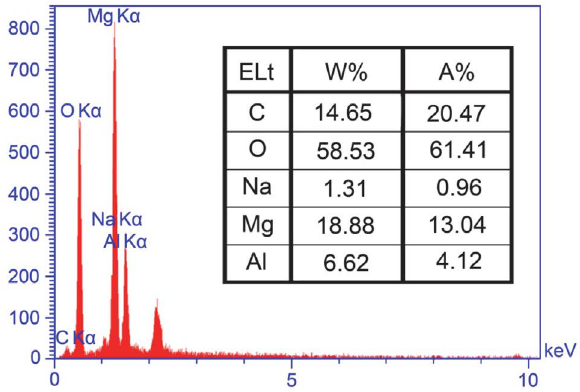
Figure 4. EDS spectrum of Mg-Al-LDH nanocompound.